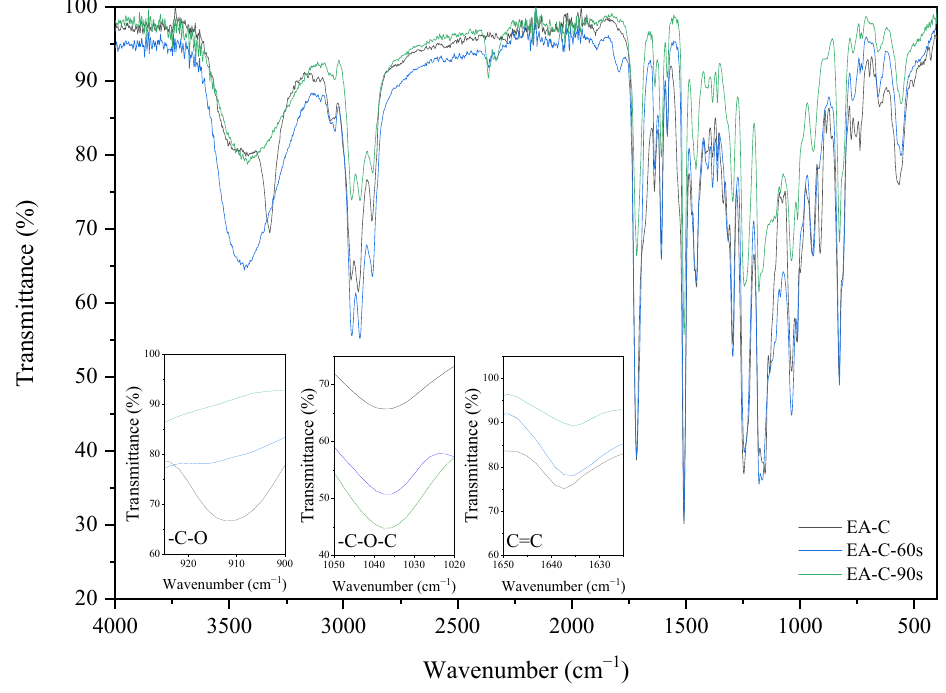
Figure 6. The FT-IR spectra of the EA-C sample before and after 60 and 90 s of UV irradiation (composition of the photoreactive formulations: 96 wt% of EA prepolymer, 4 wt% of cationic PI).